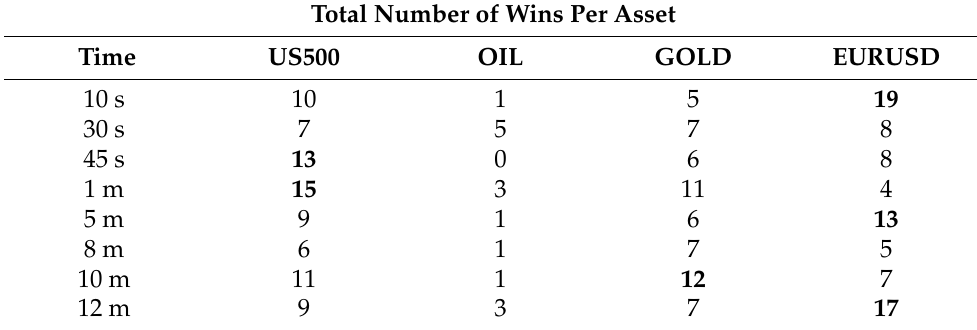
Table 1. A closer look at the details. Each cell contains the total number of positive outcomes (maximum 25), for each combination of asset and observation time frames. Highlighted in bold are assets that achieved a substantial amount of wins in their observation time.